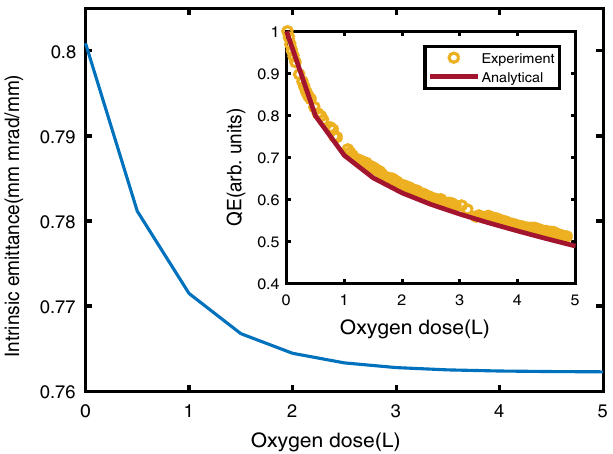
FIG. 3. The predicted time evolution of intrinsic emittance of Cs 3 Sb from analytical model is presented as the blue line. The working condition, including oxygen pressure of 10 − 9 Torr and photon energy of 3.06 eV, is the same as in Ref. [23]. The inset shows the model fitting to Pavlenko ’ s paper [23], which gives a L of 6.1 nm, shown in Table I. 1 Langmuir equals to 10 − 6 Torr d